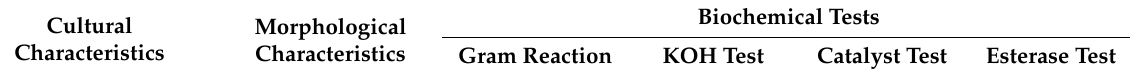
Table 3. Cultural and morphological characteristics of Xanthomonas oryzae pv. oryzae